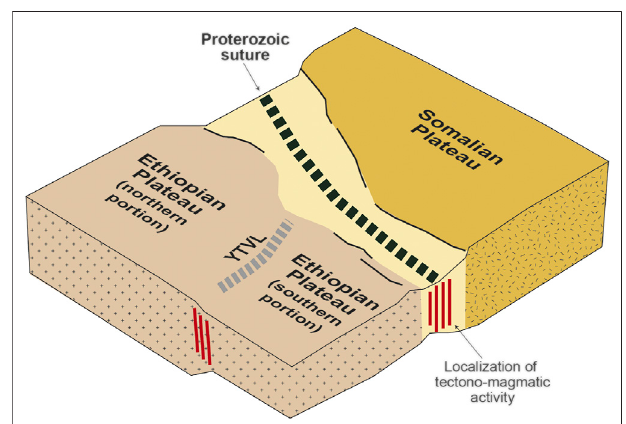
FIGURE 2 | Pre-rift lithospheric domains and location of Cenozoic volcano-tectonic activity in the MER (modi fi ed from Keranen and Klemperer, 2008). Cenozoic extension follows the rheological boundaries between two distinct Proterozoic basement terranes, underlying the Ethiopian and Somalian plateaus; this lithospheric weakness zone corresponds to an ancient suture zone (see text for